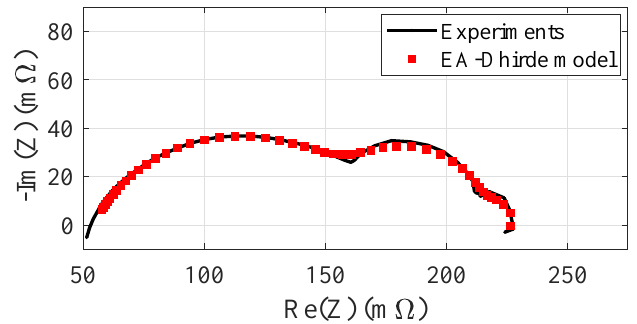
Figure 7. Dataset B. Normal conditions. Identification of Dhirde